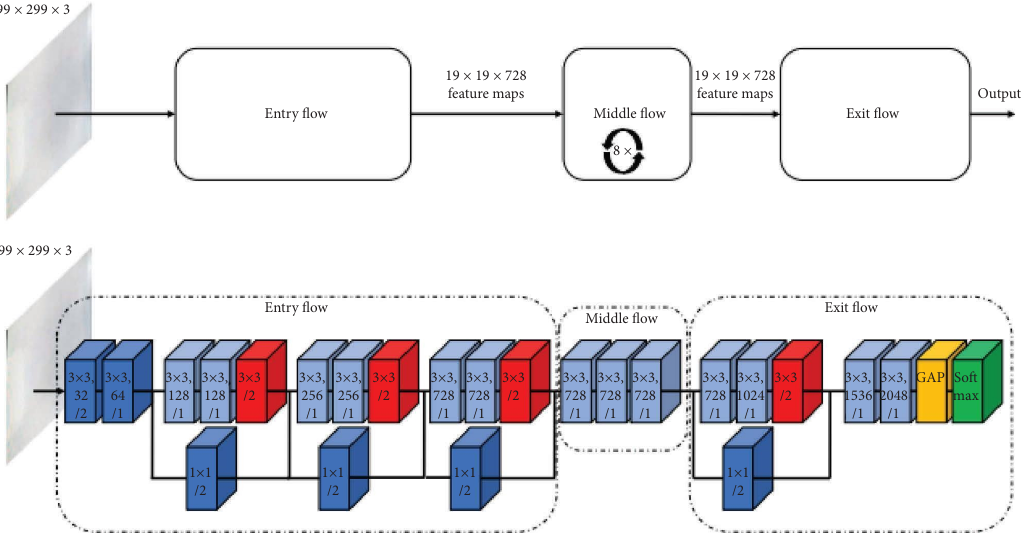
Figure 7: Xception